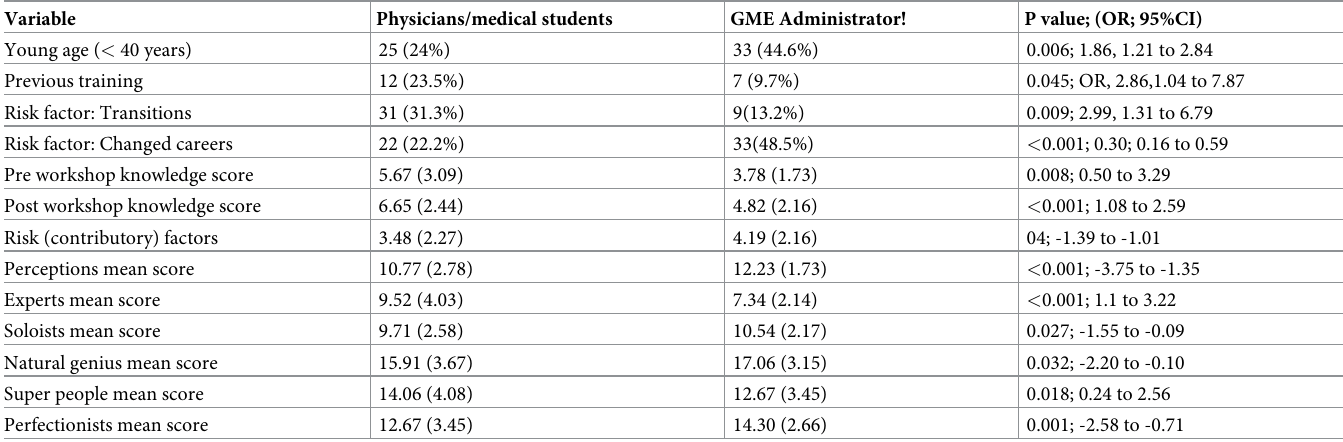
Table 3. Significant findings of comparisons between GME administrators (n = 71) versus physicians and medical students (n = 75).